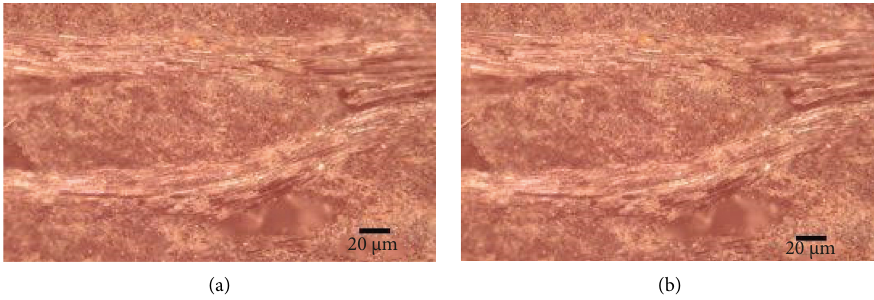
Figure 14: Optical microscope images of cured composite samples (100X